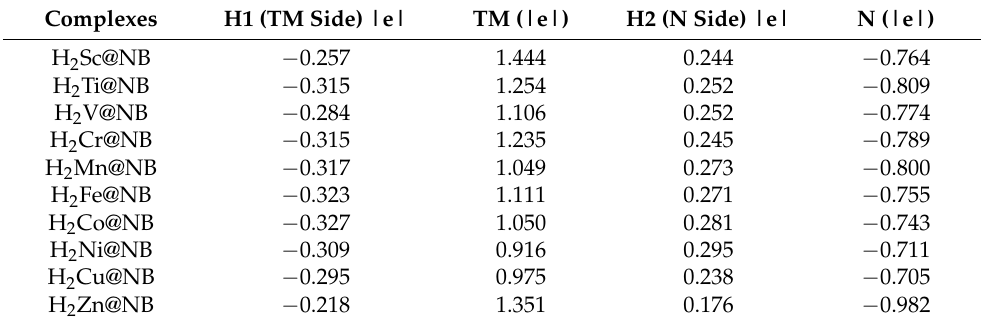
Table 3. NBO charge transfer analysis of stable H 2 TM@NB complexes.